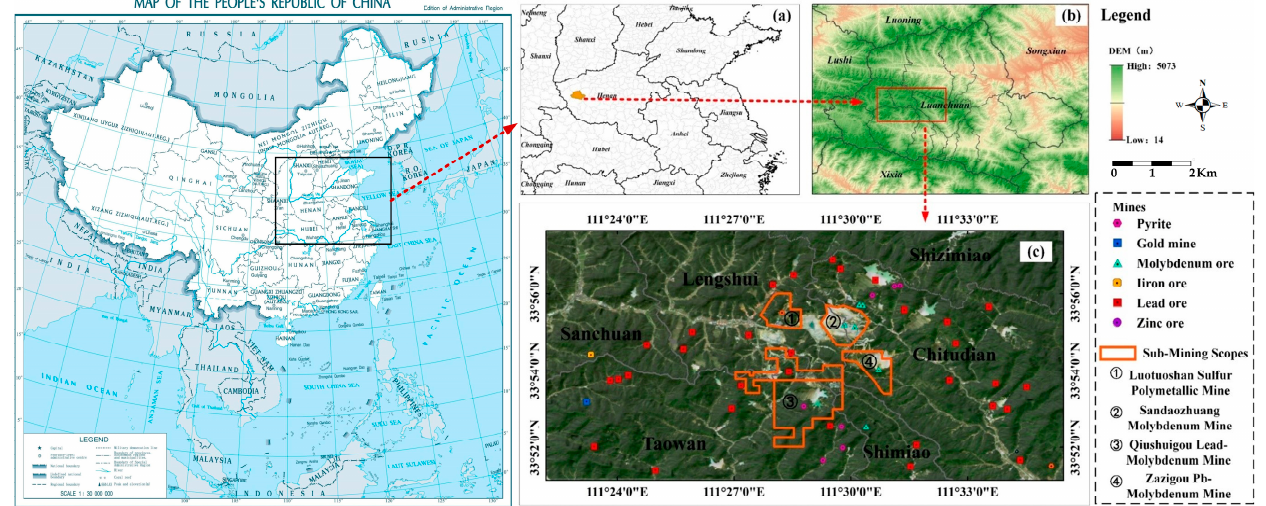
Figure 1. Location of Luanchuan County, Luoyang City, Henan Province ( a ); location of the Lu- anchuan mining concentration area ( b ); mine distribution location of Luanchuan mining concentration area ( c